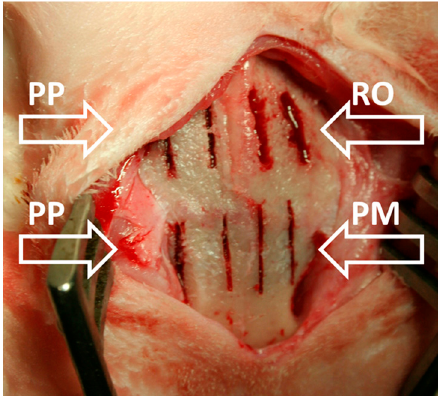
Figure 1. Gross photograph showing the osteotomies performed in each rabbit skull: two by means of rotary bur (RO), two by means of Piezosurgery ® Medical (PM), and four by means of Piezosurgery ® Plus (PP) (as indicated by arrows).